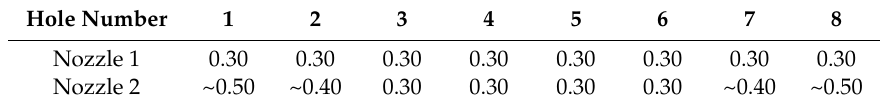
Figure 4. Photos of nozzle 1 ( a ) and nozzle 2 ( b ). Table 1. Diameters of nozzle orifices, mm.